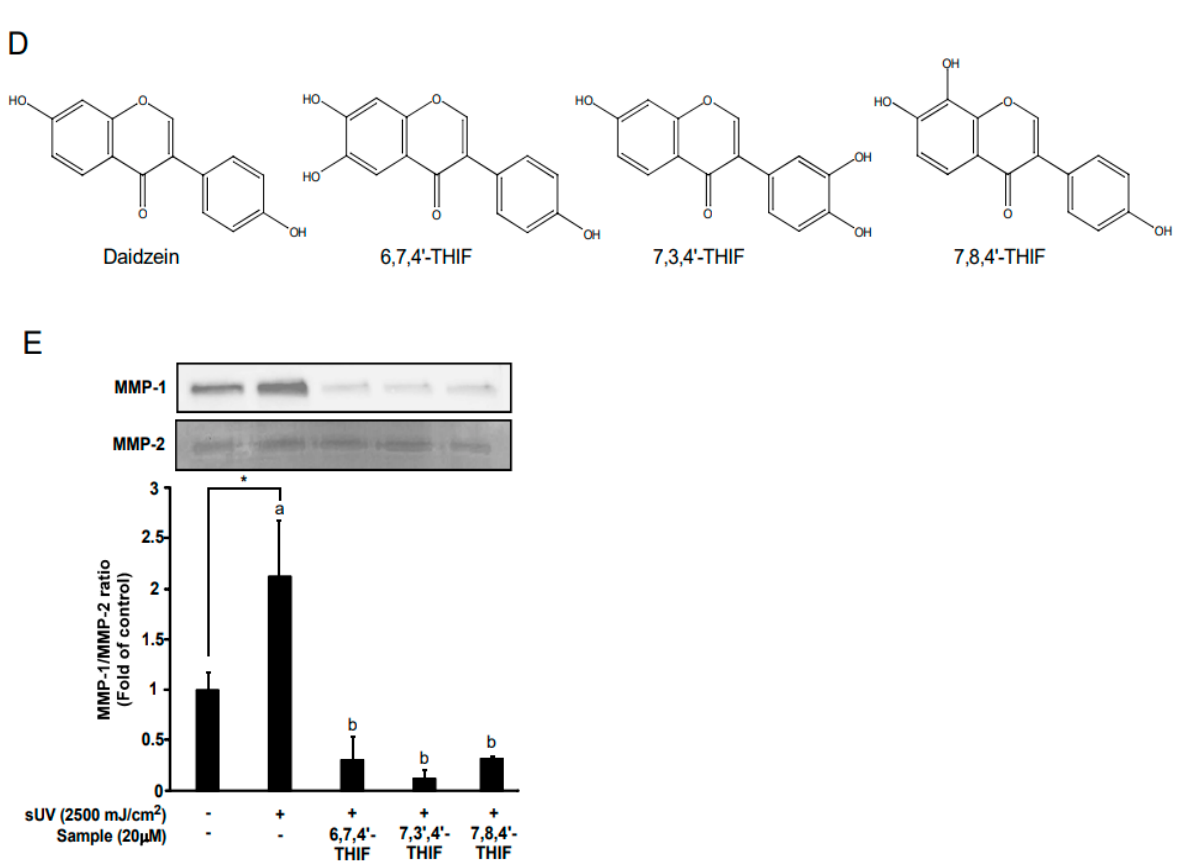
Figure 7. The main isoflavone metabolites of EFY exert the inhibitory effects of MMP-1 secretion. ( A ) Heatmap analysis of metabolite profiling of fermented and unfermented Yak-kong. The top 25 ranking metabolites (increased or decreased) were selected according to VIP values and presented against EFY and UFY as heat map. ( B ) The volcano plot for major metabolites increased in EFY. Twelve metabolites are shown with a difference of more than twice ( p < 0.05) between EFY and UFY. ( C ) Quantification of daidzein, 6,7,4 ′ -THIF, 7,3 ′ ,4 ′ -THIF, and 7,8,4 ′ -THIF before and after fermentation. Data ( n = 3) are mean values ± SD. ** significant difference ( p < 0.01) and *** ( p < 0.001) between UFY and EFY. ( D ) Molecular structures of daidzein, 6,7,4 ′ -THIF, 7,3 ′ ,4 ′ -THIF, and 7,8,4 ′ -THIF. ( E ). Inhibitory effects of 6,7,4 ′ -THIF, 7,3 ′ ,4 ′ -THIF, and 7,8,4 ′ -THIF on sUV-induced MMP-1 protein secretion in HaCaT cells. The data represent mean values ± SD ( n = 3). * significant difference ( p < 0.05) between the control and sUV-induced control. Mean values with different letters indicate statistically significant differences among sUV-exposed groups ( p < 0.05). Representative western blots from three independent experiments are shown ( n = 3).